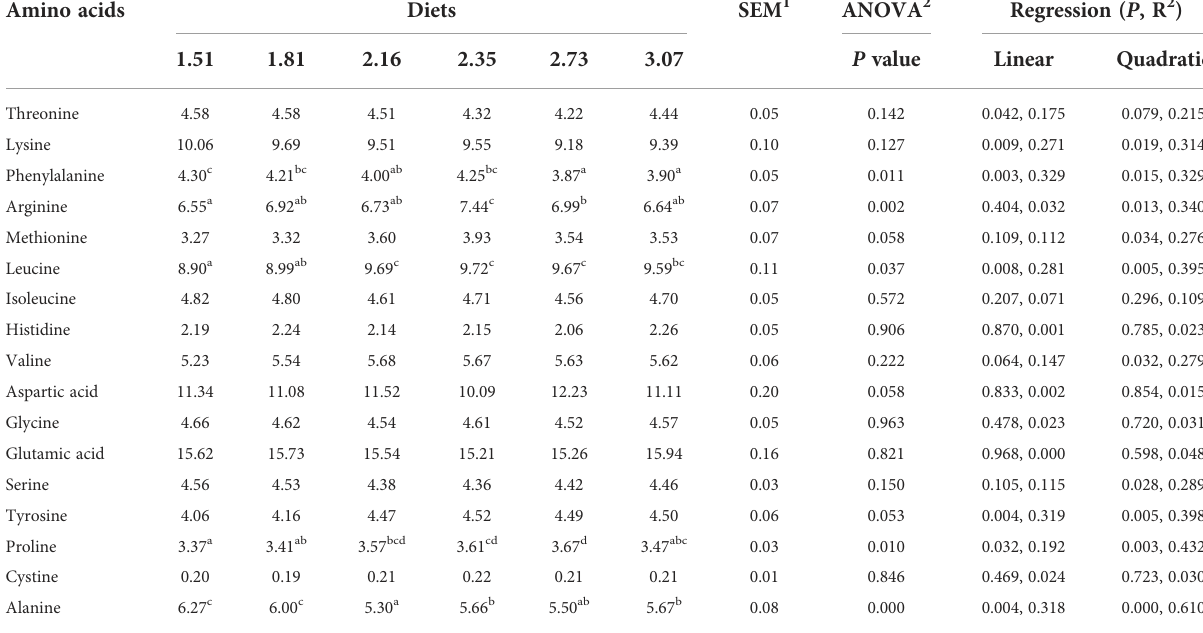
Means in the same row with different superscripts are signi fi cantly different (P< 0.05). 1 SEM: pooled standard error of